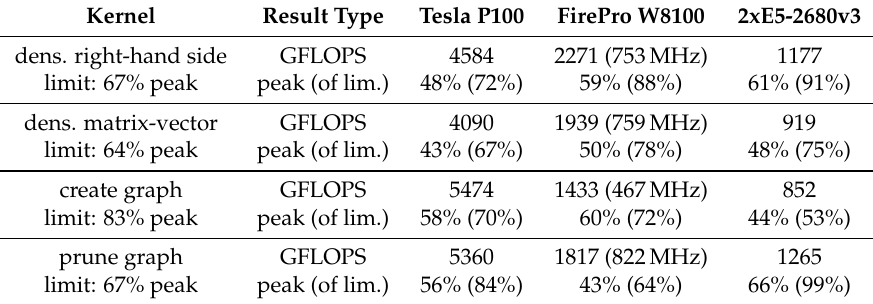
Table 5. The node-level performance of the clustering algorithm. All results are for single-precision arithmetic. The performance was measured with the 10M-10C dataset and the parameters listed in Table 4. Note that the achievable peak performance is limited by the instruction mix to values significantly below